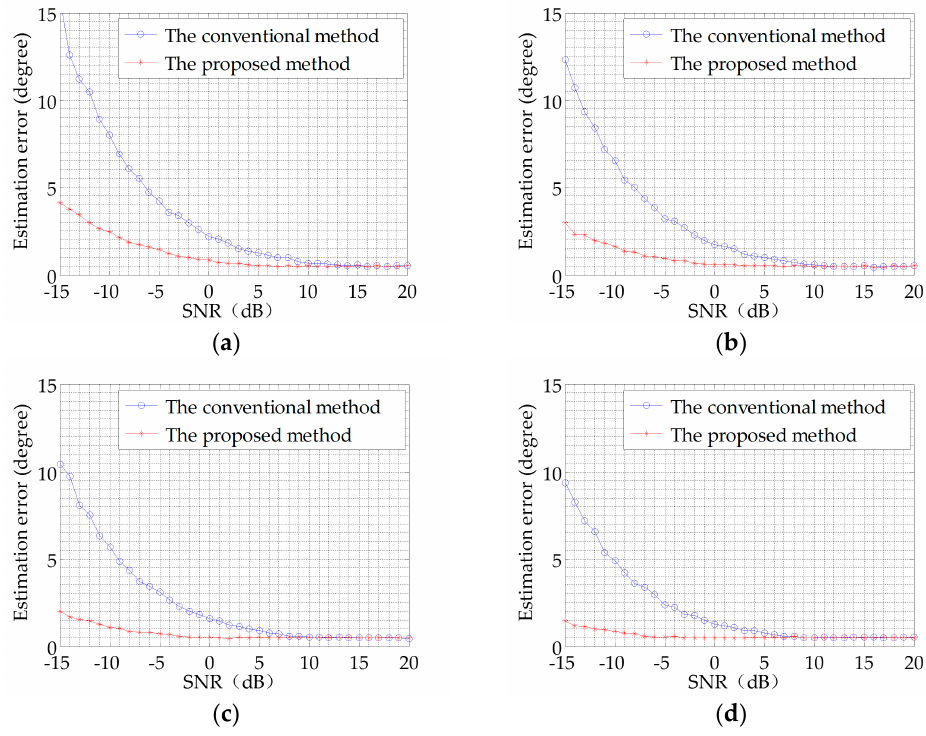
Figure 7. Comparison of DOA estimation error between two methods: ( a ) the signal length is 0.2 s; ( b ) the signal length is 0.5 s; ( c ) the signal length is 1 s; ( d ) the signal length is 2 s.